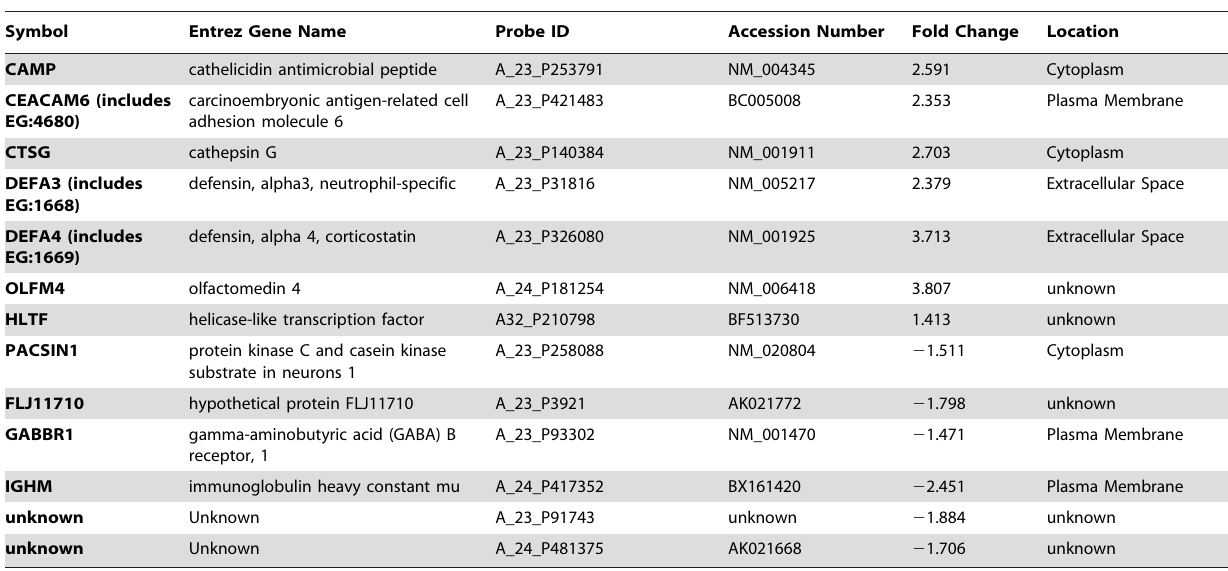
Table 5. Differentially-expressed genes between mild and severe cases of IPF.